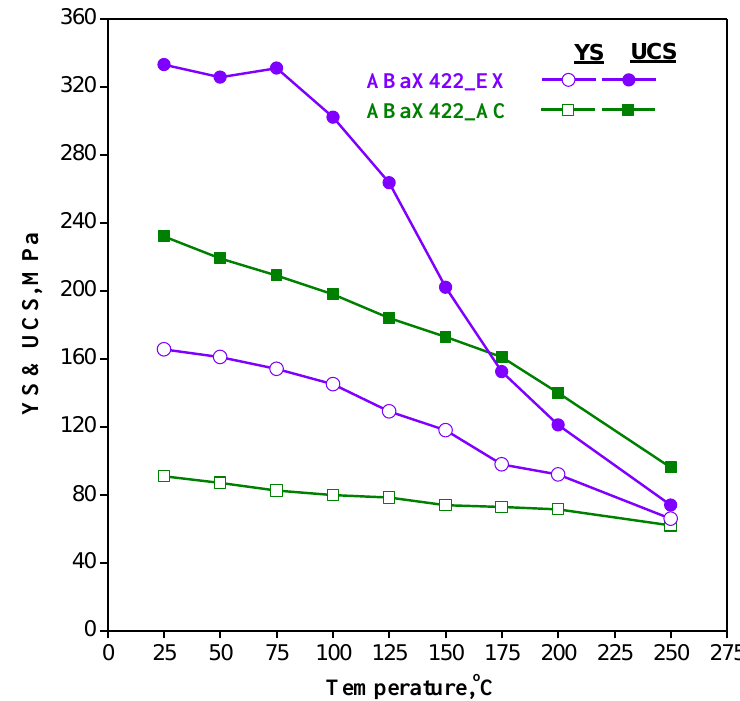
Figure 11. Compressive yield and ultimate compressive strength of the ABaX422 alloy in the as-cast and extruded conditions.